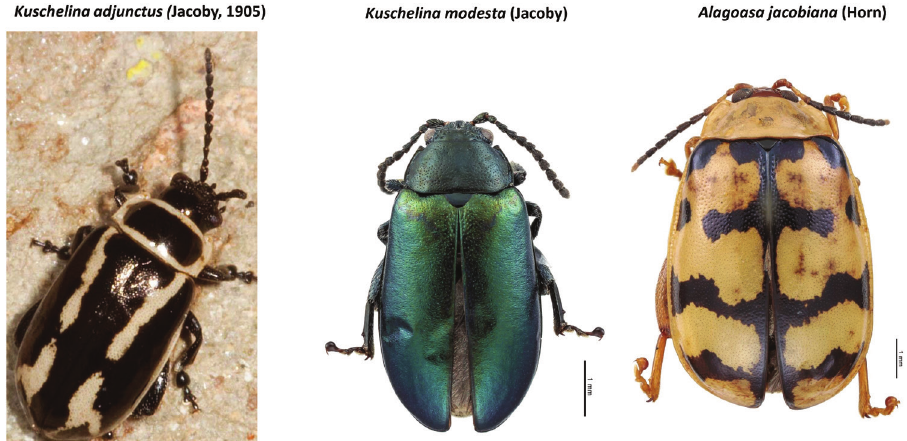
Figure 17. Alagoasa and Kuschelina generic